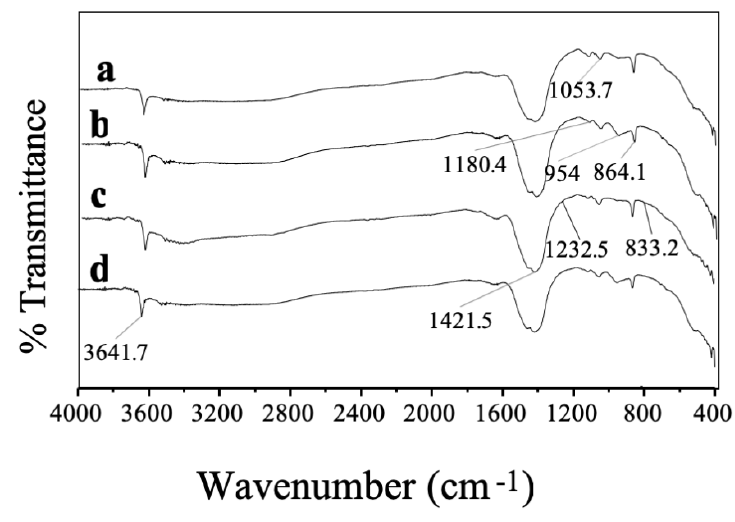
Figure 1. Fourier-transform infrared spectrometry (FT-IR) spectra of Potassium Hydroxide (KOH)-impregnated eggshell samples at various KOH concentrations (wt%): ( a ) 10%, ( b ) 15%, ( c ) 20%, and ( d ) 25% at 800 °C for 5 h.